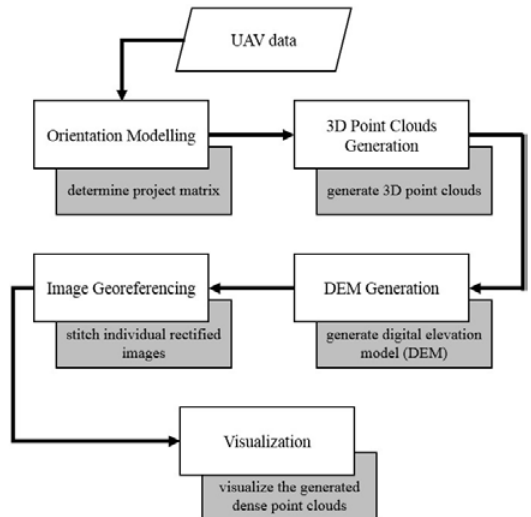
Figure 1. Main processes of proposed educational modules Table 1. Overall curriculum of educational modules Modules Tasks and learning objectives